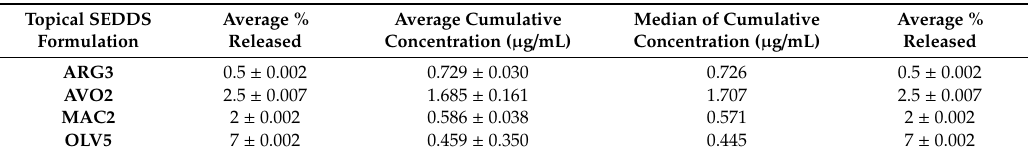
Table 4. Data obtained for membrane release studies after 6 h. Average cumulative concentration is presented as mean ± standard error, whereas average percentage released is displayed as mean ± standard